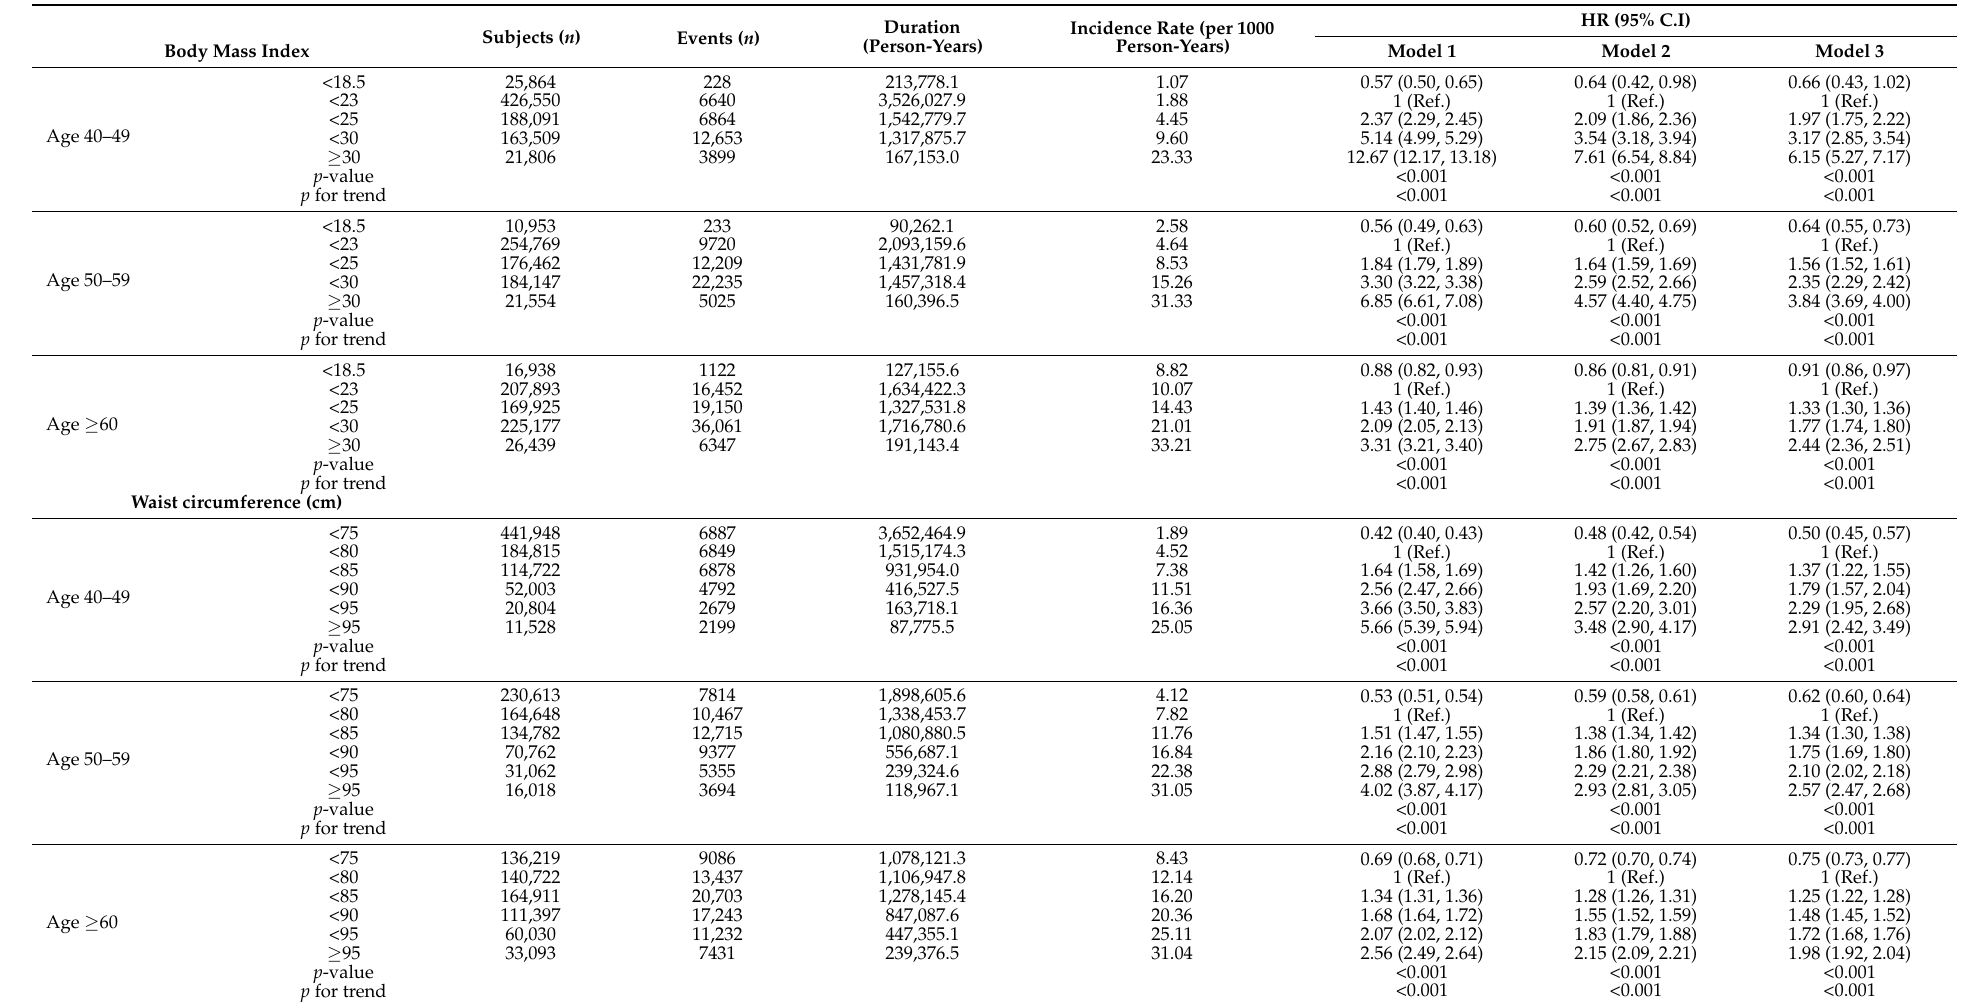
Table 3. Associations between body mass index, waist circumference, and type 2 diabetes risk by age